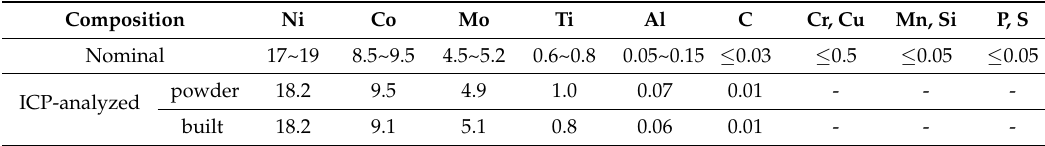
Table 1. Nominal and measured compositions of the investigated powdered and bulk maraging steels (wt. %), analyzed using inductively coupled plasma-atomic emission